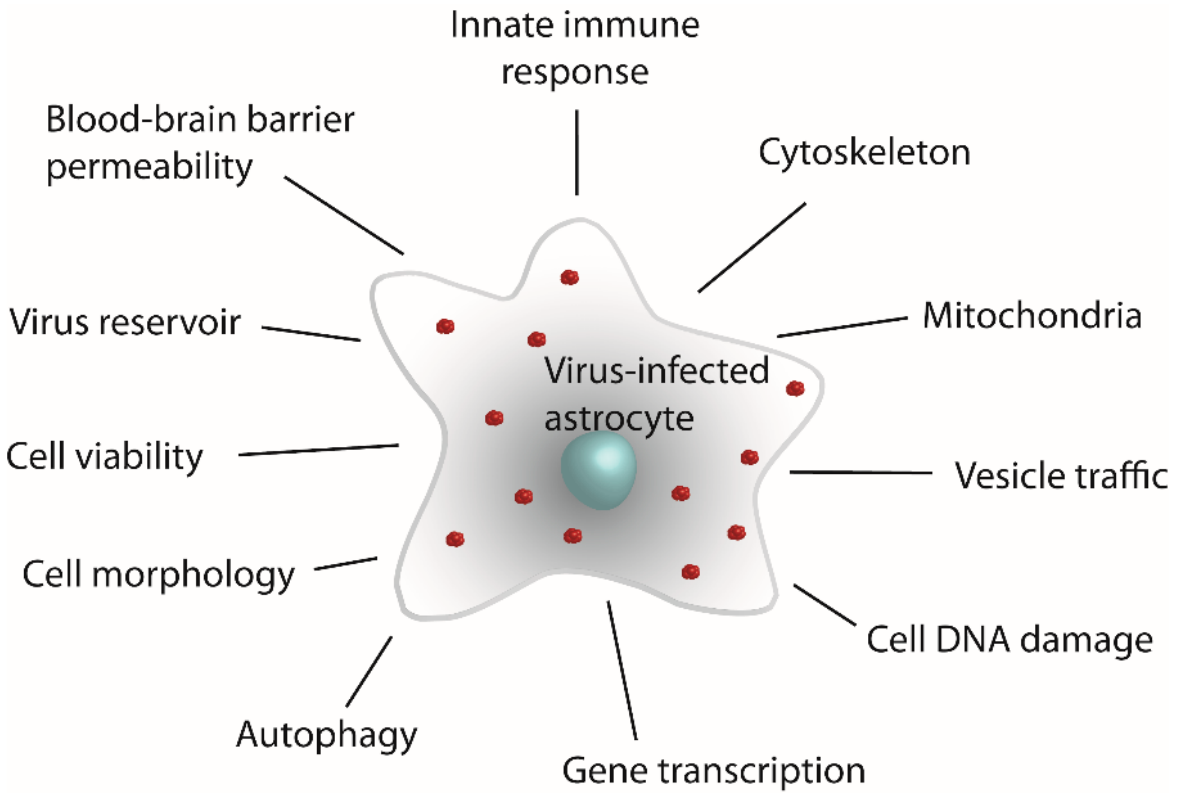
Figure 1. Viral infection of astrocytes affects a set of cellular processes that alter the morphologic and physiologic properties of these cells. The schematic depicts an astrocyte infected with virus (red clusters) and cellular entities and processes that undergo changes triggered by viral infection.